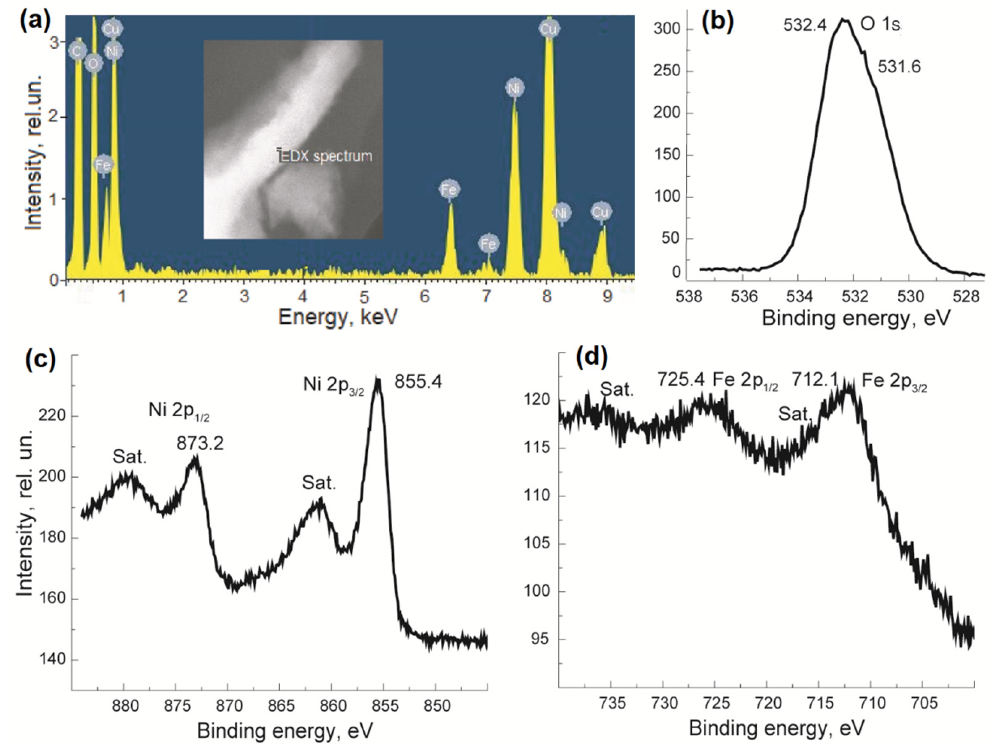
Figure 4. EDX spectrum ( a ) and XPS O1 s ( b ), Ni2 p ( c ), and Fe2 p ( d ) core levels spectra of nanoparticles forming the microcapsule wall.